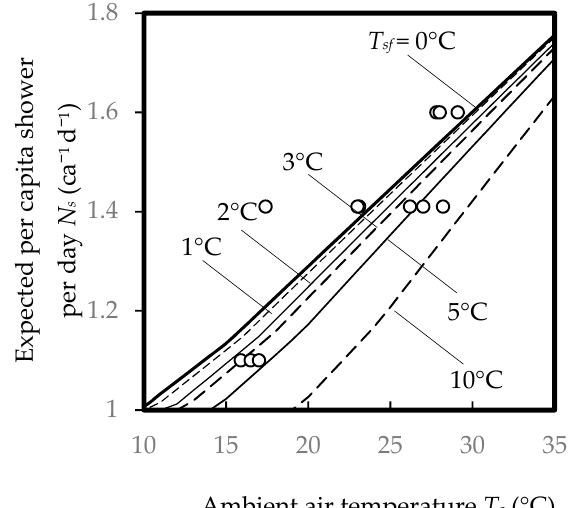
Figure 2. Expected number of showers per occupant per day N s .